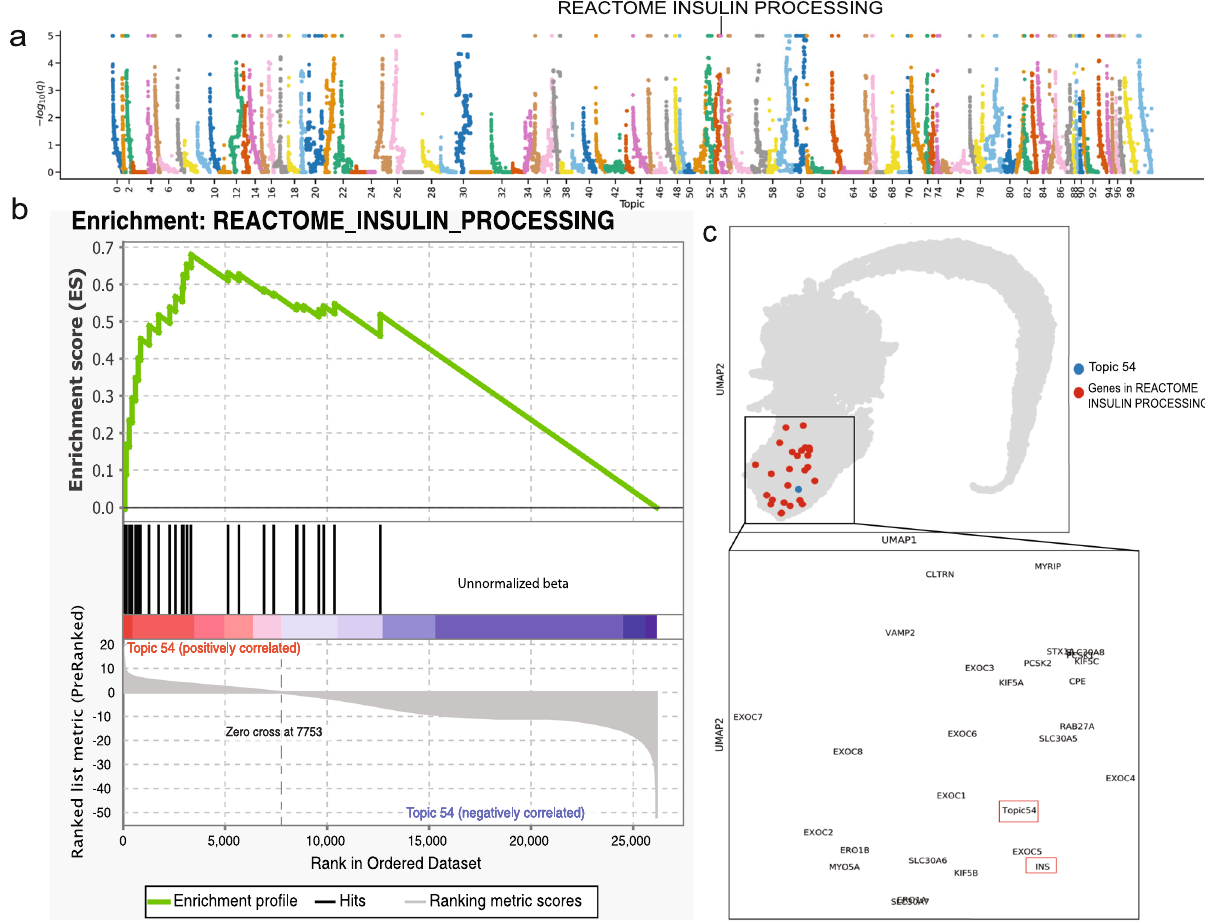
Fig. 5 Gene set enrichment analysis of the Human Pancreas dataset. a Manhattan plot of the GSEA results on the 100 scETM topics learned from the HP dataset. The x-axis is the topic and the y -axis is the -log q -value from the permutation test corrected for multiple testings by the BH-method. The dots correspond to the tested GSEA gene sets. The maximum -log q -value is capped at 5. b Leading edge analysis of Insulin Processing (IP) pathway using Topic 54. The genes are ranked by the topic score (i.e., the unnormalized topic mixture beta) under Topic 54. The running sum enrichment score was calculated by GSEA. The black bars in the middle indicate the genes that are found in the IP pathway. Topic 54 is signi fi cantly enriched in Insulin Processing pathway (GSEA permutation test BH-adjusted q -value = 0). c UMAP visualization of the gene and topic embeddings learned from the HP dataset. Genes in IP are colored in red and Topic 54 in blue. The inset box displays a magni fi ed view of the cluster zooming into the IP pathway genes (including Insulin ( INS )) that are near Topic 54 in the embedding